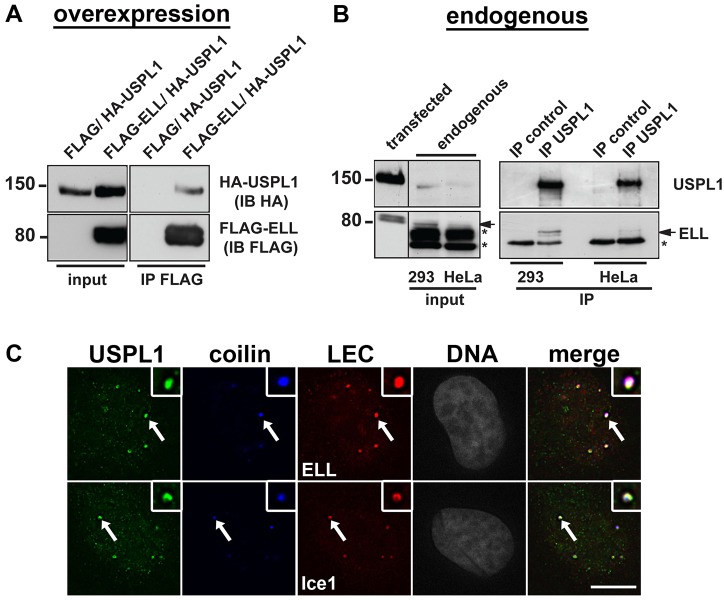
USPL1 colocalises and interacts with members of the LEC complex. (A) Total cell lysate obtained from HEK293 cells 24 hours after transfection with the indicated plasmids were subjected to immunoprecipitation using an anti-FLAG antibody. 1.5% of the total lysate was loaded as input (left). Bound proteins were analysed by immunoblotting using an anti-HA or anti-FLAG antibody (right). (B) Total cell lysate from either HEK293 (293) or HeLa cells was subjected to immunoprecipitation using the USPL1 antibody. Input corresponds to 1% of the total cell lysate (left) and a cell lysate sample of HEK293 cells transfected with either HA–USPL1 or FLAG–ELL was loaded onto the same gel as positive control for USPL1 or ELL, respectively. Empty Protein-G–agarose beads served as immunoprecipitation control. Bound proteins were analysed using either the USPL1 antibody or ELL antibody (right). The arrow indicates endogenous ELL, non-specific bands recognised by the ELL antibody are marked with asterisks. (C) Colocalisation of either ELL (top) or Ice1 (bottom) with USPL1 and coilin in Cajal bodies (arrows) shown by immunostaining of HeLa cells. Scale bar: 10 µm.